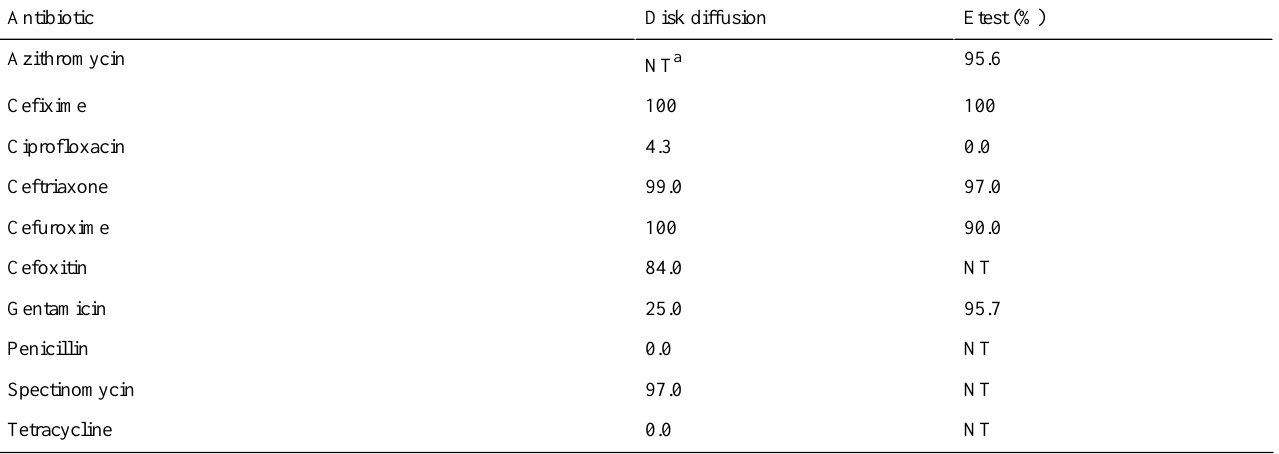
Table 4. Percentage of isolates susceptible to the antibiotic tested.